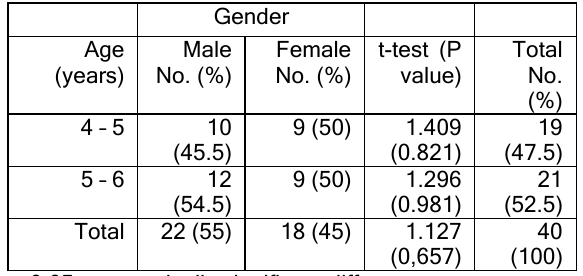
Table (3) demonstrated the distribution of autistic children classified according to age and gender.